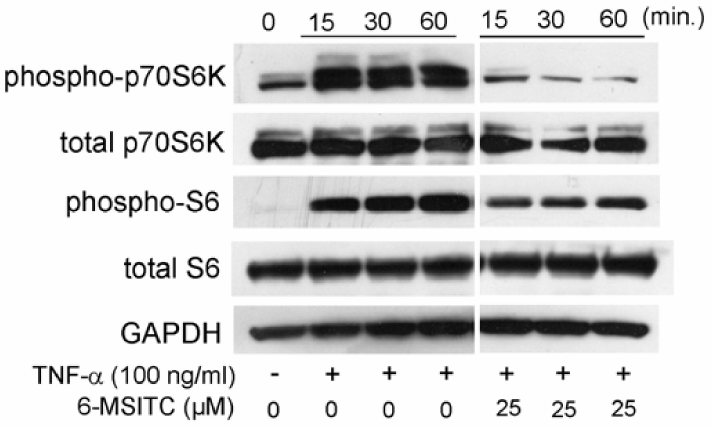
Figure 5. 6-MSITC mediated inhibition of a p70S6K-S6 pathway in TNF- α stimulated TR146 cells. After pretreatment with 6-MSITC (25 µ M) for one hour, TR146 cells were stimulated with TNF- α for 15, 30, or 60 min, and then phosphorylation of p70S6K and S6 was determined by Western immunoblotting. The figure reports the results of a representative experiment performed three times with qualitatively comparable